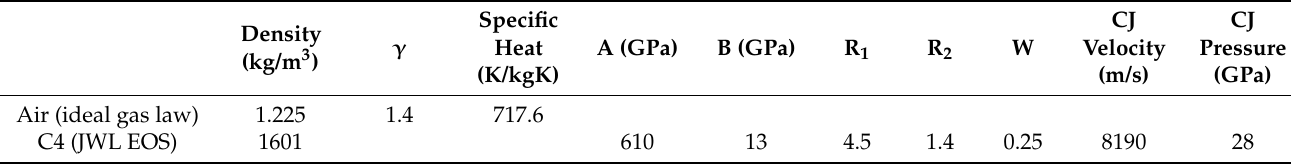
Table 1. Properties of air and C4 used in the simulations.